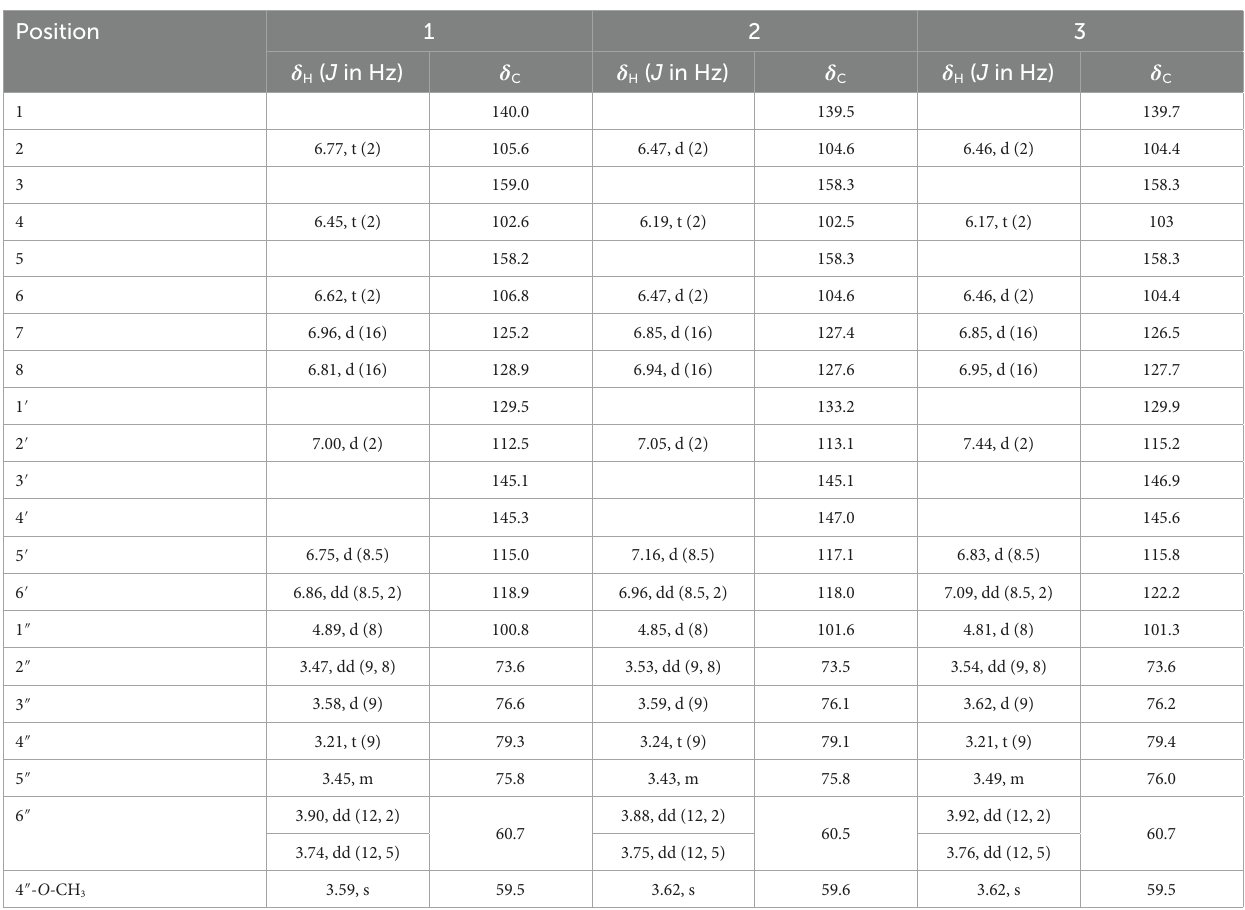
(Supplementary Figure S14); 1 H NMR (CD 3 OD, 500 MHz); and 13 C NMR (CD 3 OD, 125 MHz) data, see Table 1 and Supplementary Figures S16-S18; HRESIMS: m/z 421.1485 [M + H] + (calcd. For C 21 H 25 O 9 , 421.1493) (Supplementary Figure S13).